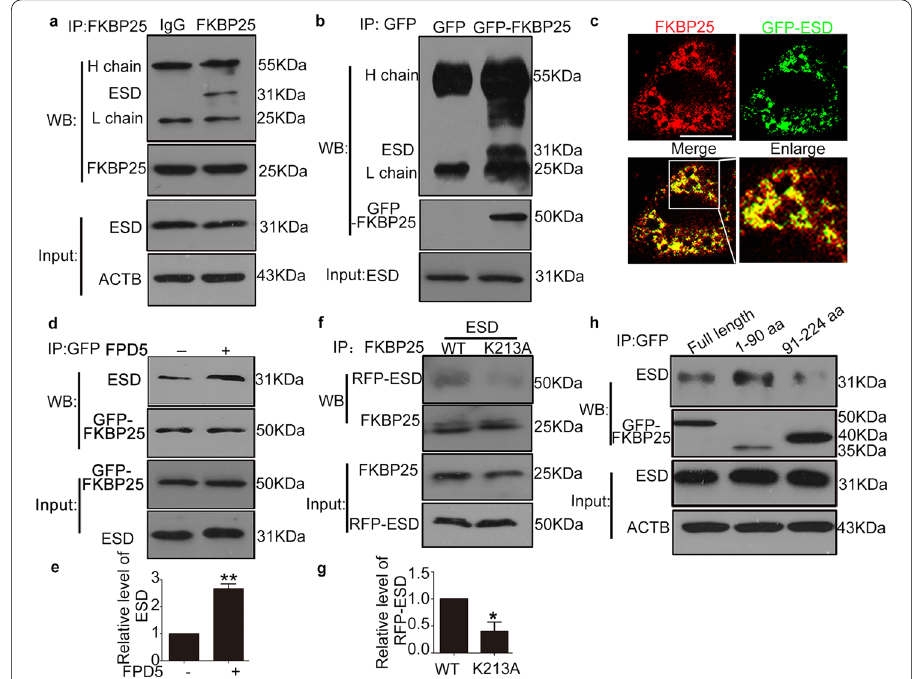
Fig. 1 ESD interacted with N-terminus domain of FKBP25 (1–90 aa). a , b Co-immunoprecipitation (Co-IP) of ESD with the FKBP25 protein or ectopically expressed GFP-FKBP25 from HEK293T cells. c Double immunofluorescence staining of GFP-ESD (green) and FKBP25 (red) showed agglomeration and co-localization in HeLa cells. Overlay of the GFP-ESD and FKBP25 with yellow indicates co-localization. Scale bar: 25 μm. d , e A549 cell line was transfected with plasmid pEGFP-FKBP25 for 24 h and then exposed to FPD5 (5 μM) for 24 h. Co-IP showed that ESD could bind more FKBP25 induced by FPD5. f , g HEK293T cell line was transfected with plasmids pCAG-ESD-WT and pCAG- ESD-K213A for 48 h. Then western blot analysis of co-immunoprecipitation of RFP-ESD with anti-FKBP25 antibodies and quantification of RFP-ESD level. h HEK293T cell line was transfected with plasmids FKBP25-WT and the deletion mutants of FKBP25 for 24 h respectively. Then the levels of GFP-FKBP25 and ESD were analyzed after Co-IP of ESD with anti-GFP antibodies. Data are mean SEM. *p < 0.05, **p < 0.01, n ± =